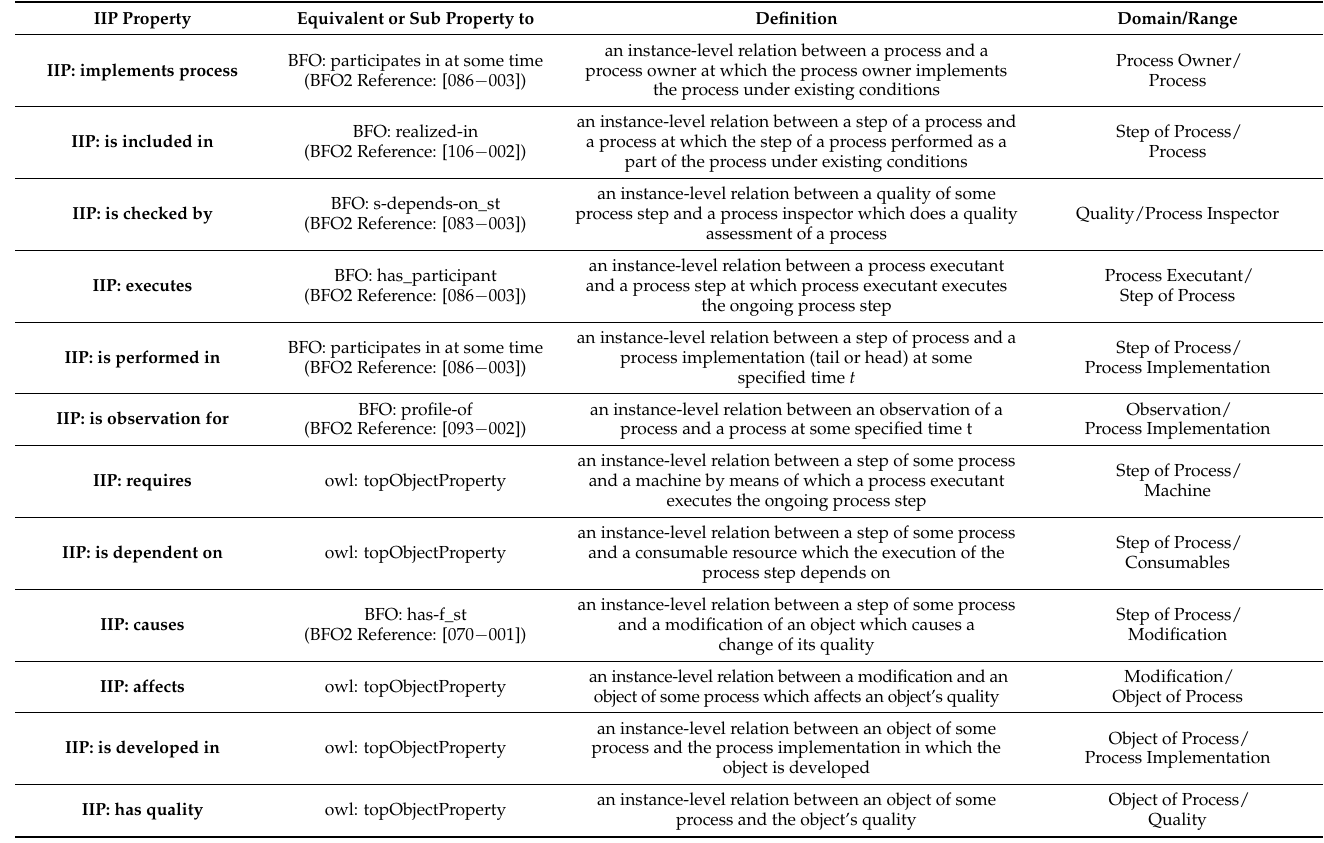
Figure 2. The main IIP classes and object properties diagram. Table 2. The list of key object properties of the Semantic reference model for individualization of information